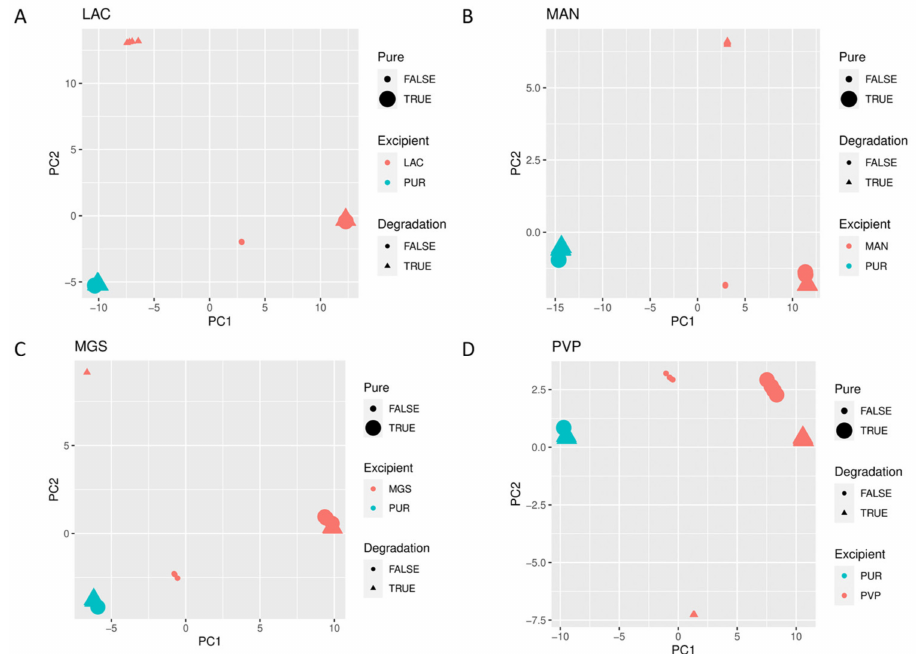
Figure 11. ( A – D ) PCA scores plots of NIR spectra of vildagliptin (Pure Drug) and the mixtures of vildagliptin with Excipients: ( A ) lactose (LAC), ( B ) mannitol (MAN), ( C ) magnesium stearate (MGS) and ( D ) polyvinylpirrolidone